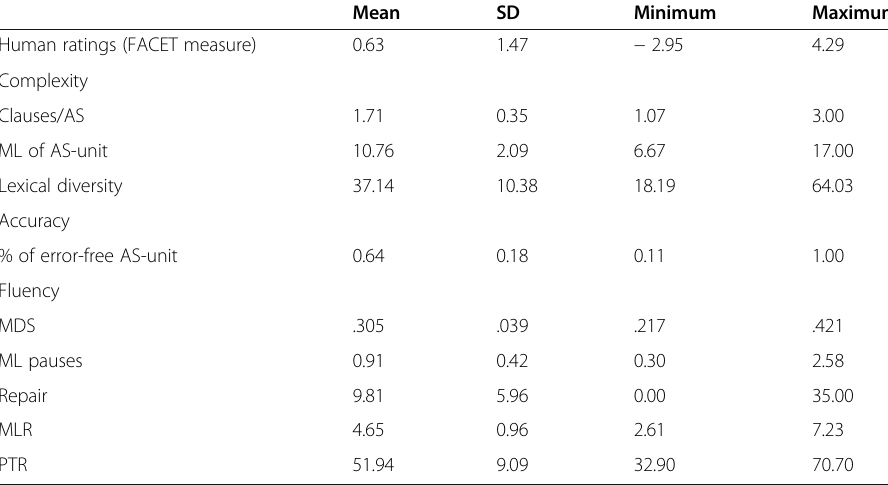
Table 7 Summary statistics of human ratings and CAF measures